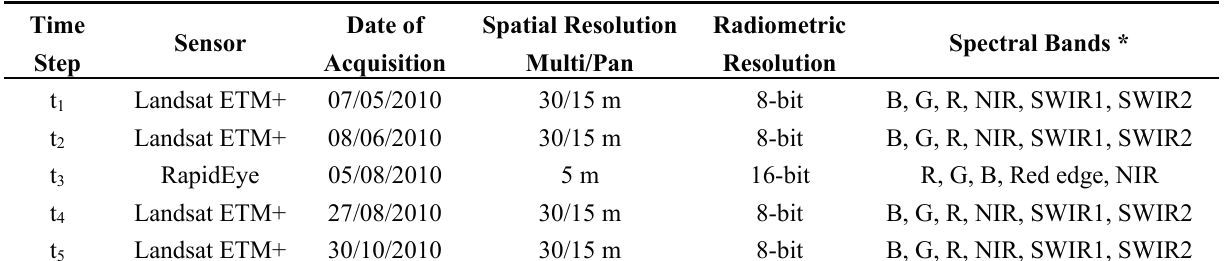
Table 1. Description of the satellite data used in the study. * : blue; G: green; R: red; NIR: near-infrared; SWIR: shortwave-infrared